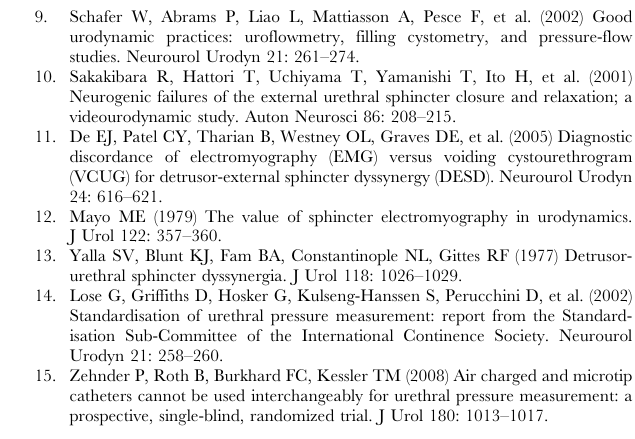
Figure S1 Female sub-group analysis: Using EUSP measurement (index test) and combined pelvic floor EMG and VCUR (reference standard), DESD was diagnosed in 5 (14%) and in 23 (64%) female patients, respectively. More than 60% of the female patients presented discordant diagnosis between the index test and the reference standard. Among 23 female patients with DESD diagnosed by combined pelvic floor EMG and VCUR, EUSP measurement identified only 3 female patients. In females, EUSP measurement had a sensitivity of 13% (95% CI 4%–32%), specificity of 84% (95% CI 57%–95%), positive predictive value of 60% (95% CI 11%–96%), and negative predictive value of 35% (95% CI 19%– 54%) for the diagnosis of DESD. (TIF) Figure S2 Male sub-group analysis: Using EUSP mea- surement (index test) and combined pelvic floor EMG and VCUR (reference standard), DESD was diagnosed in 5 (14%) and in 18 (50%) male patients, respectively. Almost half of the male patients presented discordant diagnosis between the index test and the reference standard. Among 18 male patients with DESD diagnosed by combined pelvic floor EMG and VCUR, EUSP measurement identified only 3 male patients. In males, EUSP measurement had a sensitivity of 16% (95% CI 5%–39%), specificity of 89% (95% CI 67%–97%), positive predictive value of 60% (95% CI 11%–96%), and negative predictive value of 51% (95% CI 33%–69%) for the diagnosis of DESD.